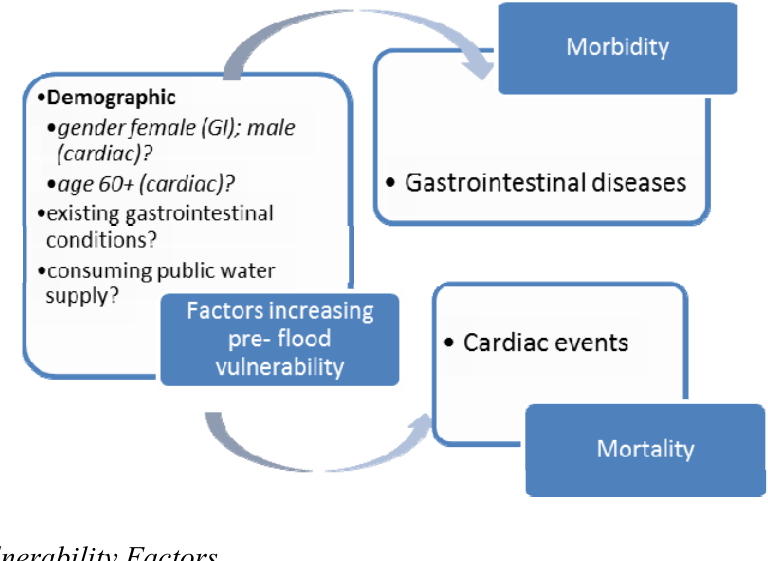
Figure 4. Risk factors increasing vulnerability to health effects before flood